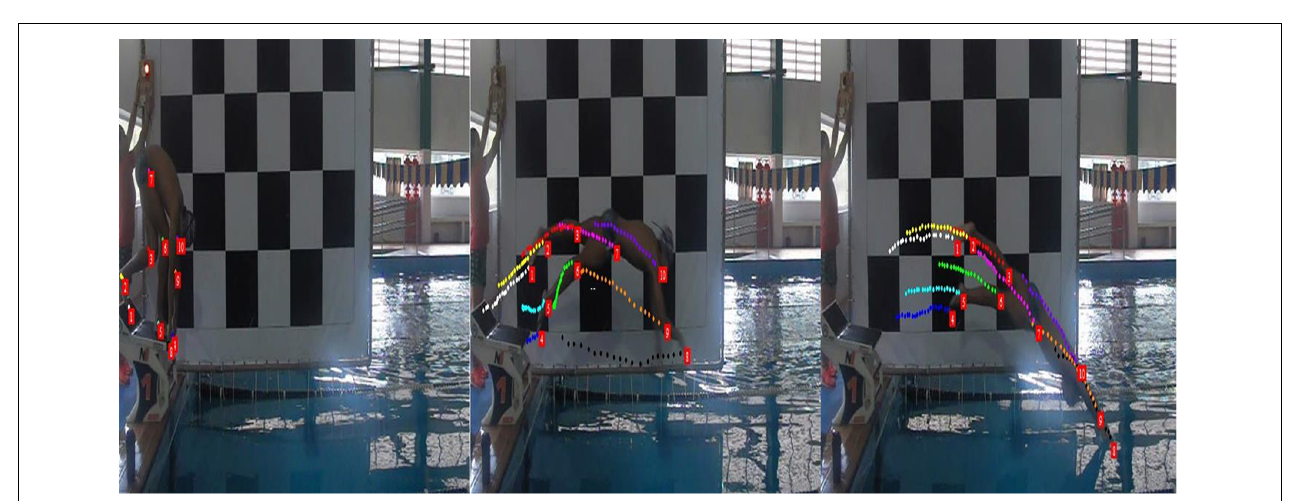
FIGURE 2 | Swimmer used markers produced with 2 × 2 cm elastic bandages on the ankle, knee, hip and shoulder axes for tracking during locomotion. Points marked on the joints of interest to determine the mechanical parameters at the time of the block exit using Dvideo R (cid:13) software was used by the Direct Linear Transformation (DLT)